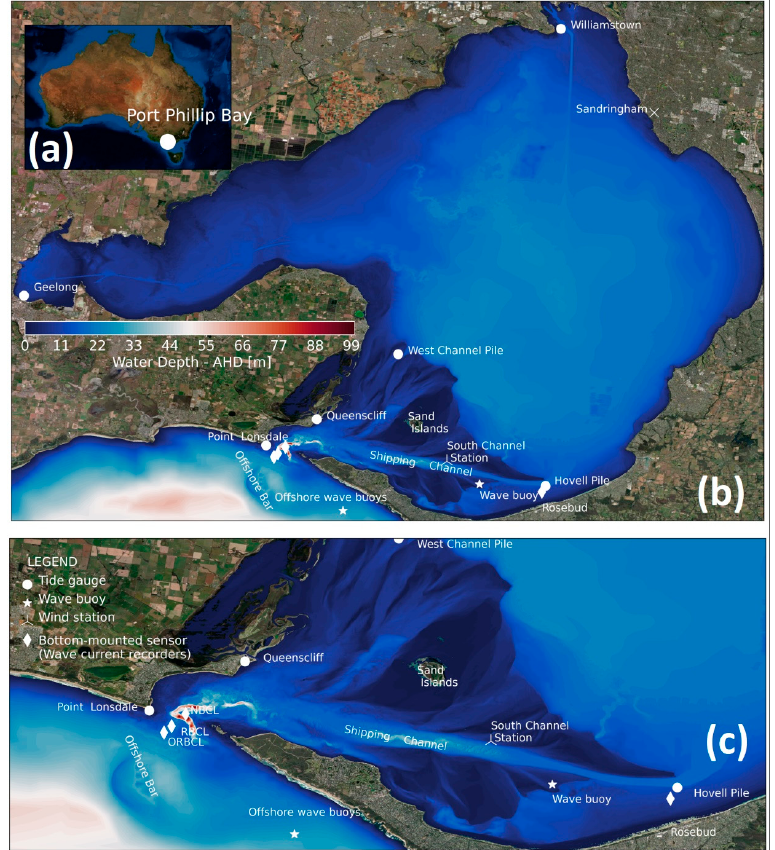
Figure 1. Location of study: ( a ) PPB location in map of Australia; ( b ) the overall bathymetry features of PPB with various observational stations used in the present study ( c ) a zoomed area showing the complexity of bathymetry within the southern portion of PPB including the entrance with various observational stations. At the entrance, there is a deep canyon up to 90 m depth at a narrow entrance where ocean waves often interact with a strong tidal current. Previously, several studies were focused on hydrodynamics in PPB regions largely used numerical models including those done by Hubbert and McInnes [8]; McInnes et al., [9–11]; and Rapizo et al., [12]. However, no study has fully addressed PPB hydrodynam- ics. Further, the reliability of previous numerical models is far from adequate. For exam- ple, Hubbert and McInnes [8] examined climate change impacts on Victorian coastlines using numerical modelling. These authors only simulated two storm events in PPB, which occurred in 1994. The major drawbacks of this study include the use of a coarse grid (a 500 m grid resolution) and that the influence of wind-waves on storm surges was not considered. Neglecting the interaction between sea levels and waves could alter the esti- mate of return levels compared to those accounted for nonlinear water level-wave de- pendency [13]. These limitations were not resolved until McInnes et al. [14] who modelled sea level extremes with the inclusion of wave setups using the GCOM2D model [8] cou-